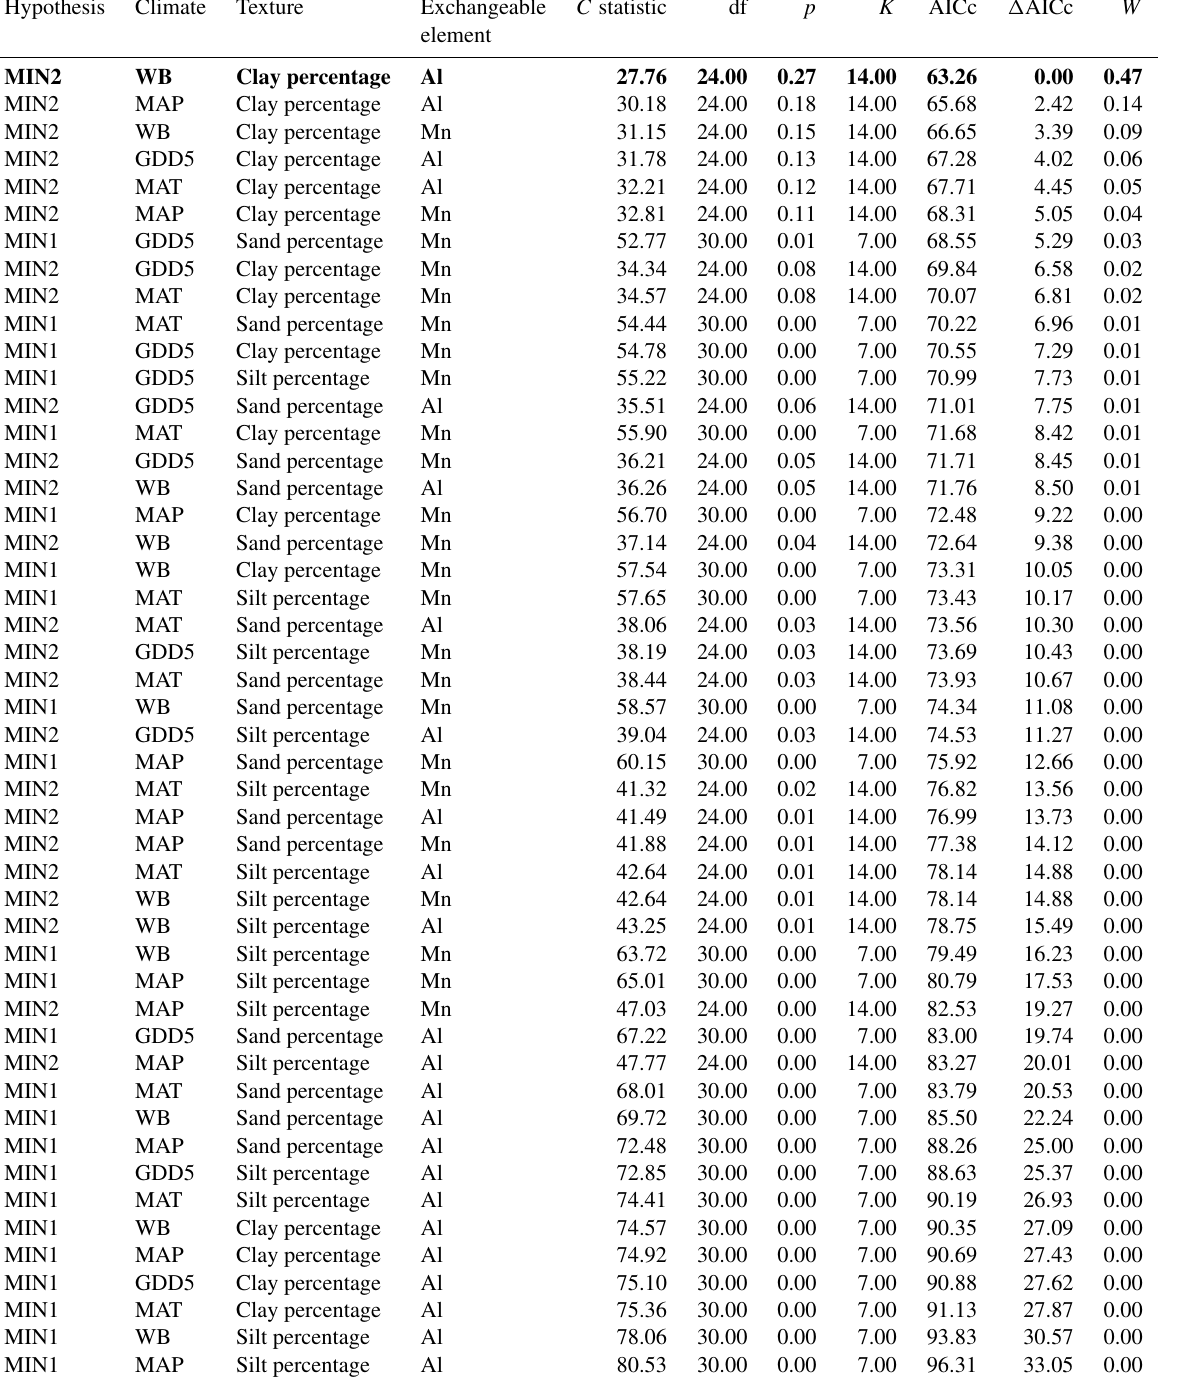
Table 4. Model fitness to the data for a priori hypotheses for the mineral soil. Models are sorted by the increasing second-order Akaike information criterion